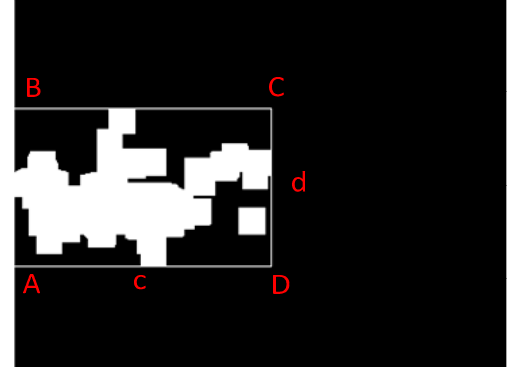
Figure 5. Enclosed rectangle of shearer cutting unit.